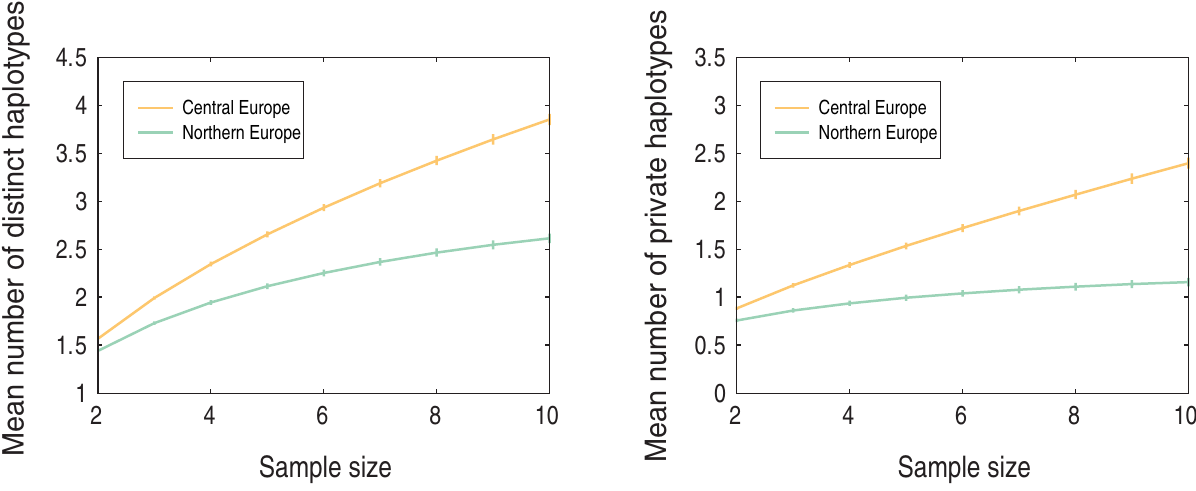
Figure 5. Number of distinct and private haplotypes. The mean number of distinct haplotypes and the mean number of private haplotypes of the central European population and the northern European population as functions of sample size. Vertical bars show standard